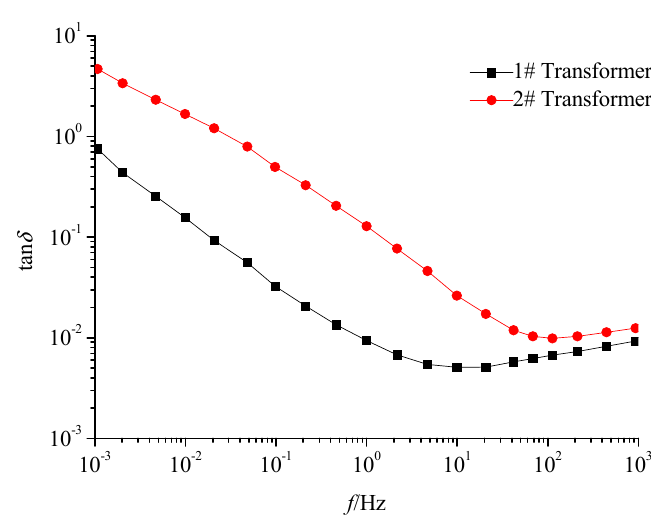
Figure 10. The tan δ curves of field transformers.